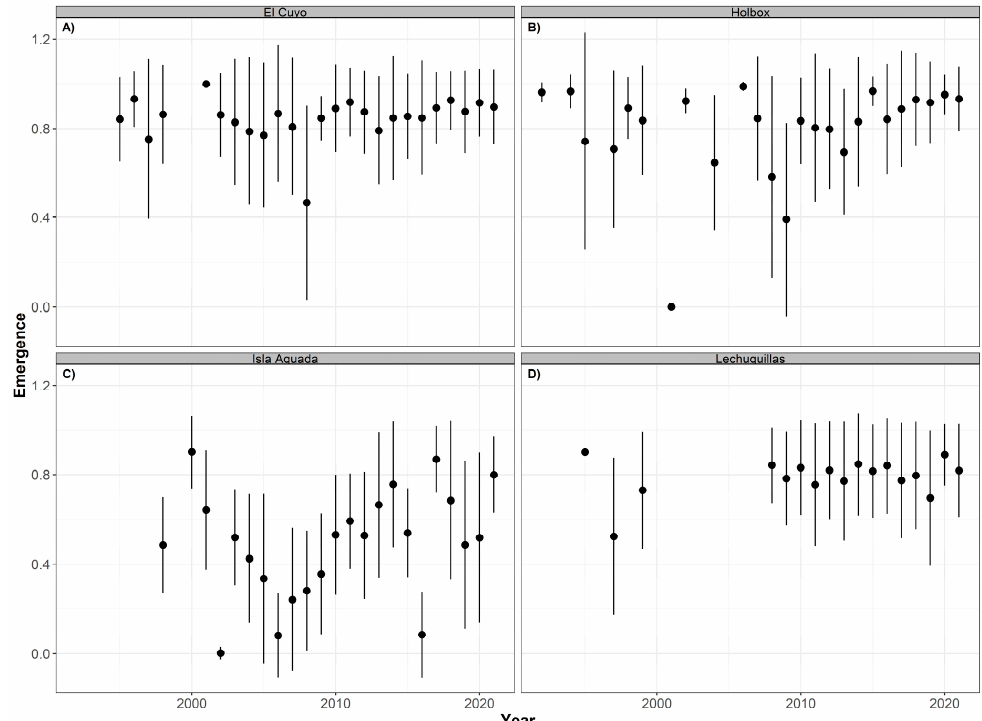
Figure 11. Time series of emergence success (annual mean ± SD) for green turtles ( Chelonia mydas ) nesting at El Cuyo ( A ), Holbox ( B ), Isla Aguada ( C ), and Lechuguillas ( D ) from 1990 to 2021.